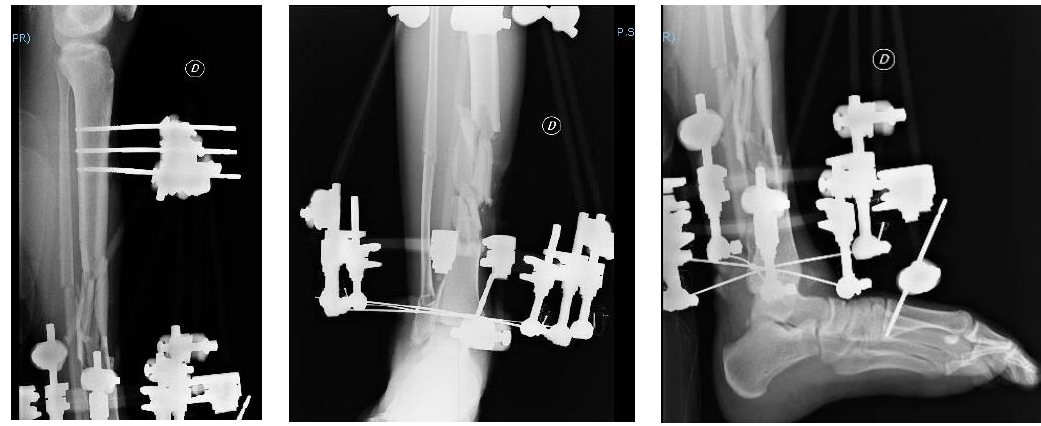
Figure 3. Post-operative radiographs; AP and LL projections of the right leg and ankle.